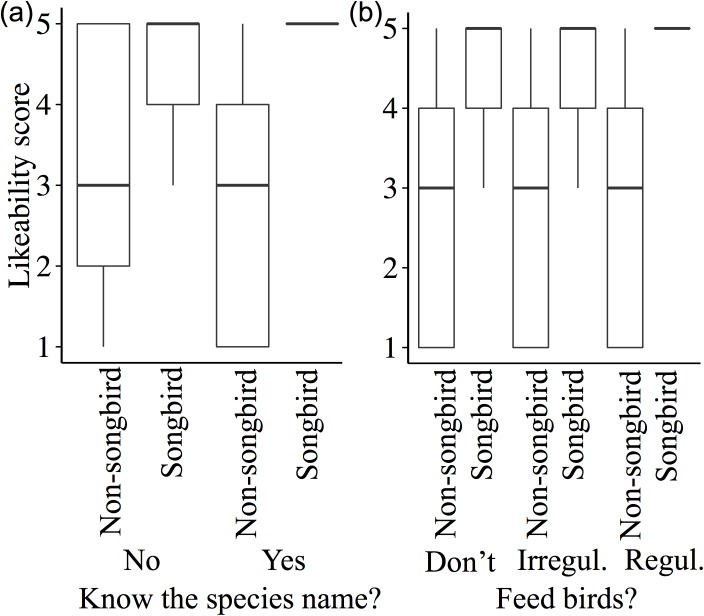
The interactions between (a) a person’s knowledge of the species name (Yes or No) or (b) how regularly they fed birds (Don’t; Irregularly “Irregul.”; Regularly “Regul.”), and whether the bird was a songbird or not (Songbird; Non-songbird), in determining the likeability of 14 common garden species (1 = strongly dislike, 5 = strongly like).